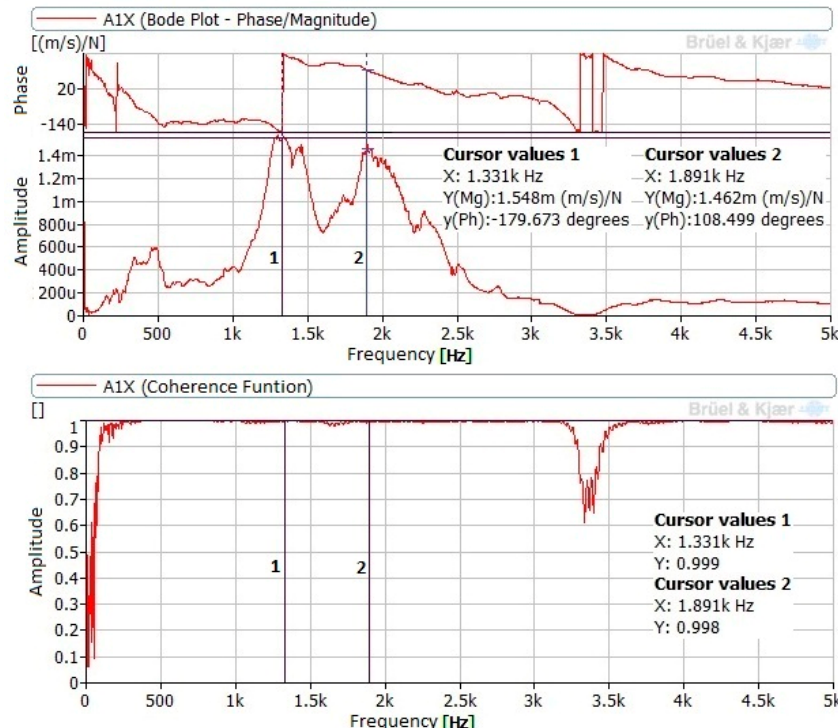
Figure 6. FRF obtained at P1 with impact at I2.